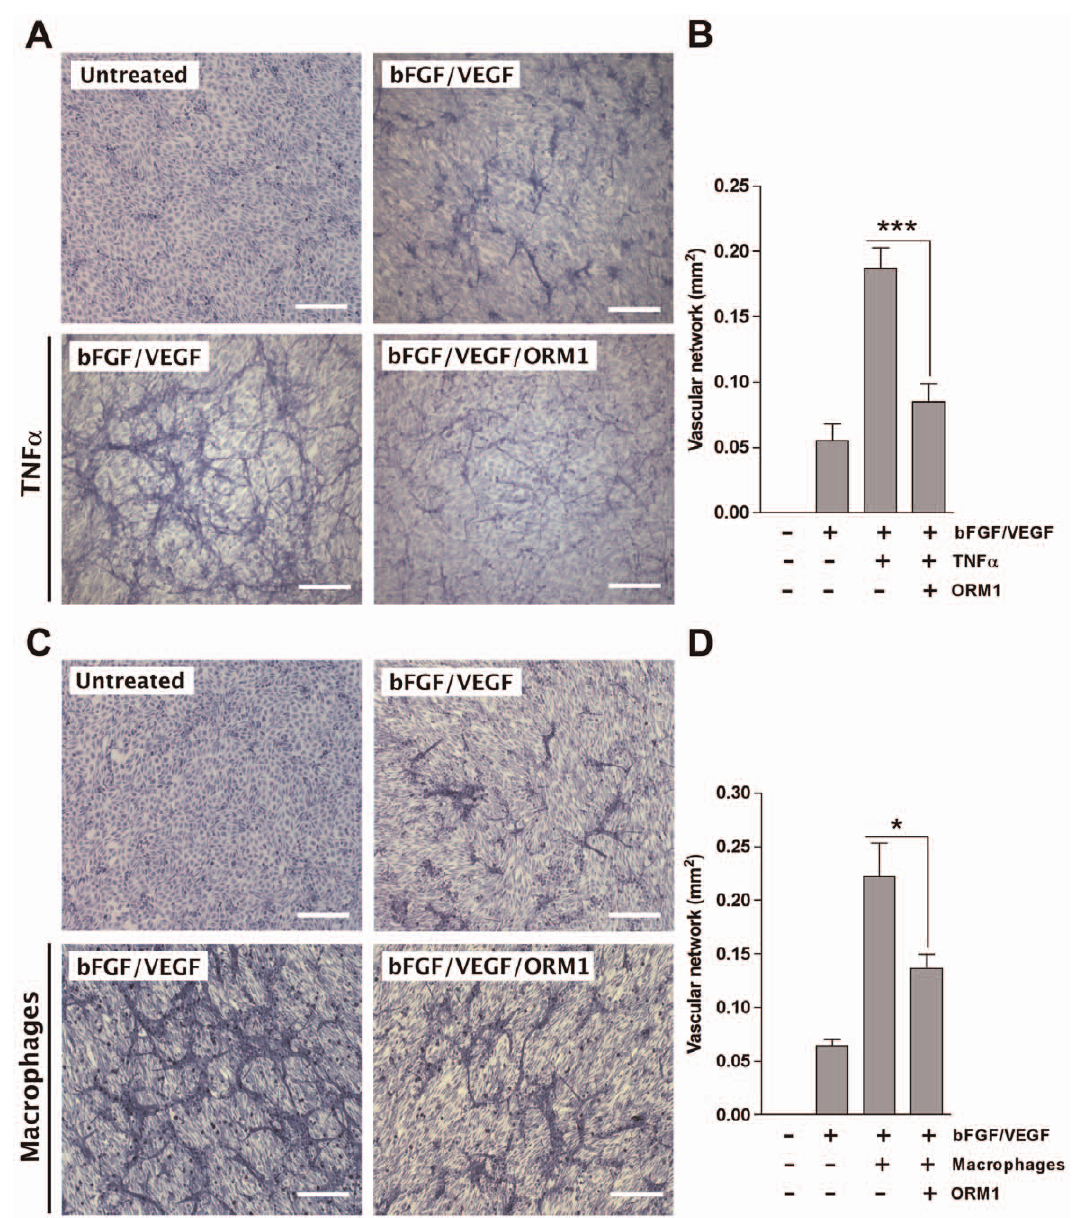
Figure 5. ORM1-priming impairs the capacity of TNF a or macrophages to promote angiogenic sprouting in a collagen invasion assay with isolated endothelial cells. (A–B). TNF a (10 ng/ml) markedly enhances formation of capillary tubes in response to bFGF/VEGF (50 ng/ ml each); priming of endothelial cells with ORM1 (100 m g/ml) completely abrogates the TNF a stimulatory effect. (C–D) Macrophages embedded in the collagen gel enhance formation of capillary tubes in response to bFGF/VEGF; priming of the endothelial/macrophage co-culture with ORM1 significantly impairs the macrophage stimulatory effect. Magnification bars=200 m m. *=p , 0.05; ***=p , 0.001.